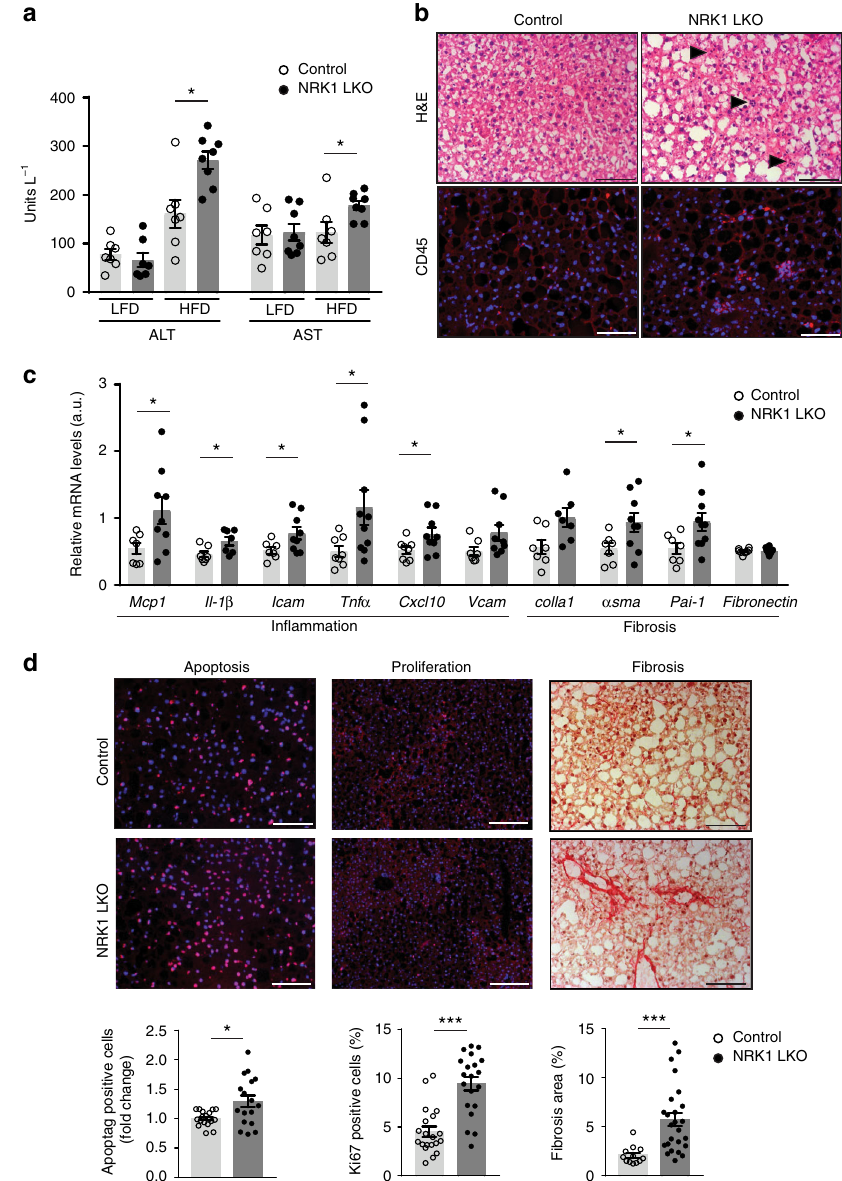
Fig. 4 NRK1 liver-speci fi c deletion fosters the development of NAFLD. a Plasma levels of liver damage markers, alanine transaminase (ALT) and aspartate transaminase (AST) in NRK1 LKO and control mice on LFD and HFD ( n = 7 for all groups except NRK1 LKO on HFD, n = 8). b Representative H&E (top) and CD45 (bottom) staining on liver sections from NRK1 LKO and control mice on HFD showing immune cells in fi ltration (black arrows) (×20 magni fi cation, scale bars: 100 μ m). c Gene expression of markers of in fl ammation (left) and fi brosis (right) in the liver of NRK1 LKO mice and control mice on HFD ( n = 8 for the control group; n = 10 for the NRK1 LKO group). d Immunohistochemistry on liver sections from NRK1 LKO and control mice on HFD. Representative staining (top) and quanti fi cation (bottom) for Apoptag (left), Ki-67 (center) (DAPI counterstaining) (×10 magni fi cation, scale bars: 200 μ m) and Sirius Red (right) (×20 magni fi cation, scale bars: 100 μ m) ( n = 4 mice per group). Results shown are mean ± SEM, * and *** indicate p < 0.05 and p < 0.001, respectively, vs. the control group. The individual values and statistical tests used for each panel can be found in the Source Data fi